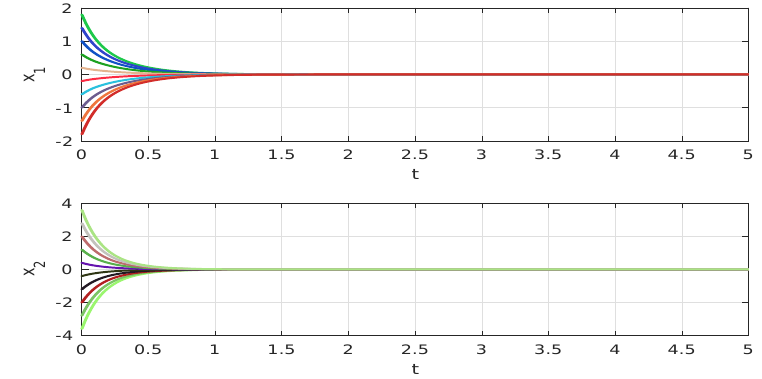
Figure 5. An illustration of the time responses with respect to the real parts pertaining to the model in (20), in which ˜ u ( t ) = 0 in Example 1.